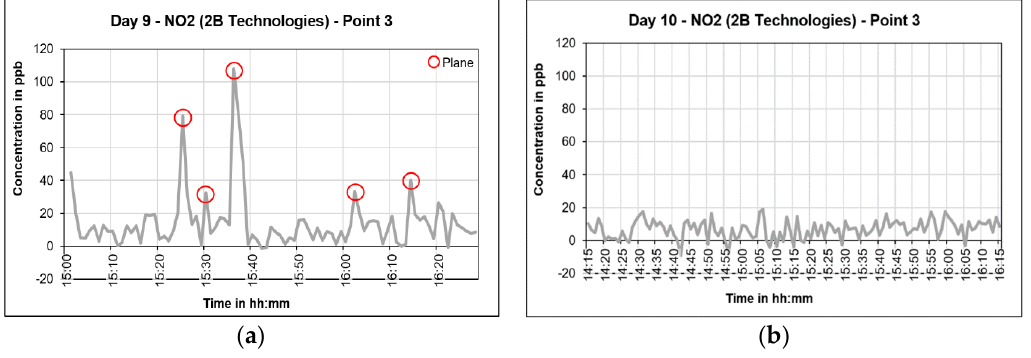
Figure 22. NO 2 concentration at point 3 on ( a ) day 9 and ( b ) day 10.